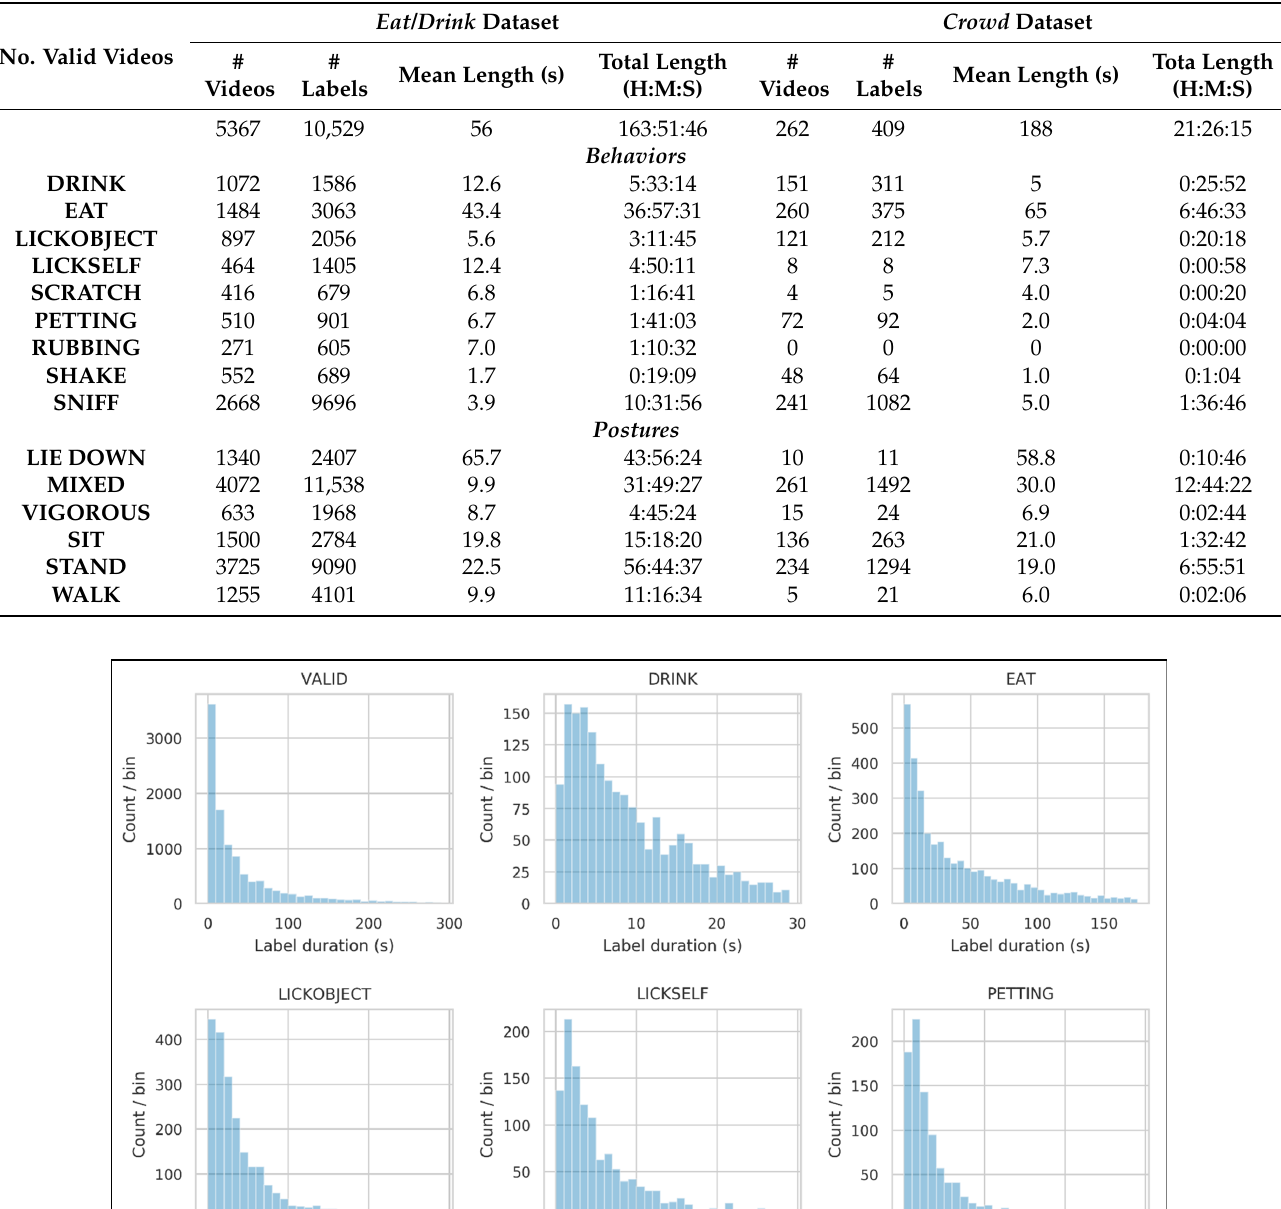
Table 5. Summary of labeled crowd and eat/drink datasets.